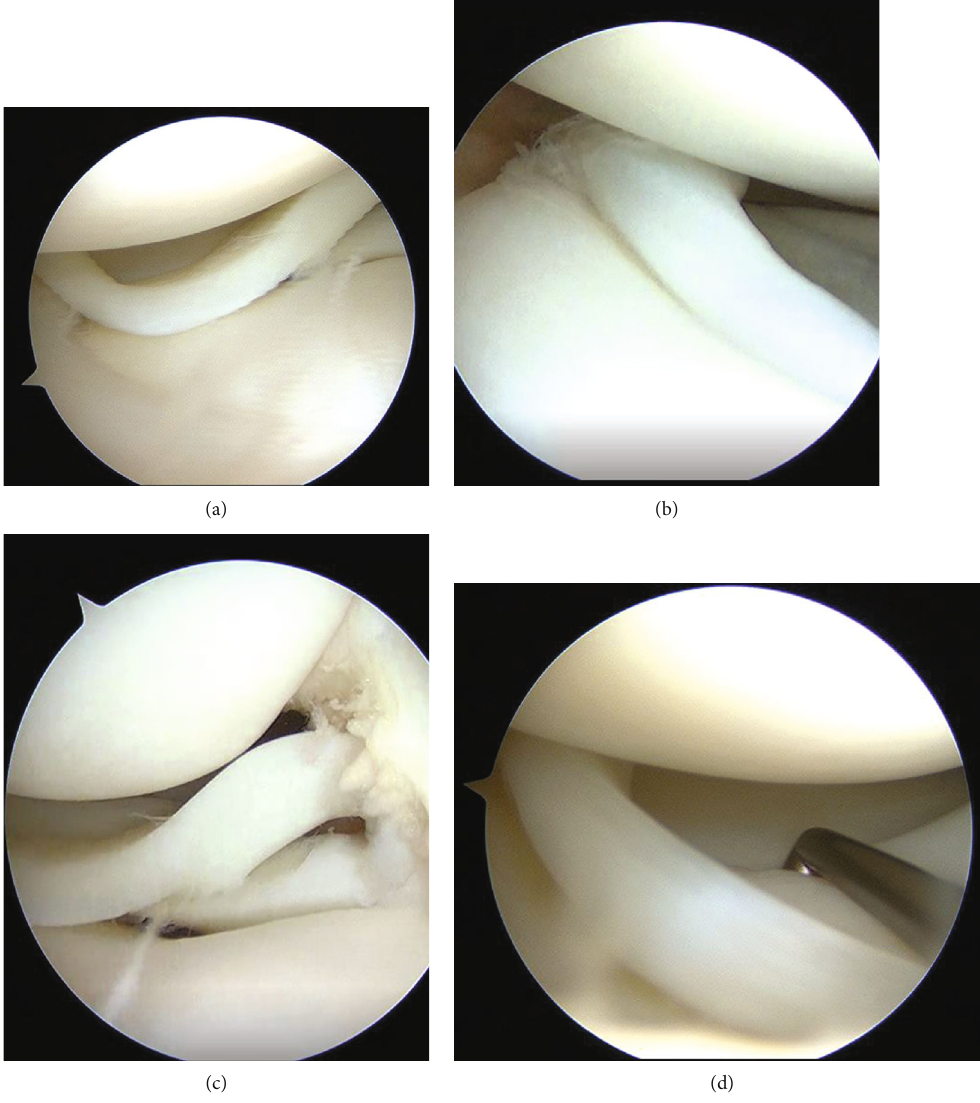
Figure 3: (a) Arthroscopic fi ndings show an accessory meniscus with a fl at surface overlying a normal lateral meniscus. (b) and (c) The accessory meniscus is fi rmly connected to the posterior horn and middle segment of the normal meniscus. (d). The accessory meniscus demonstrated favorable mobility by